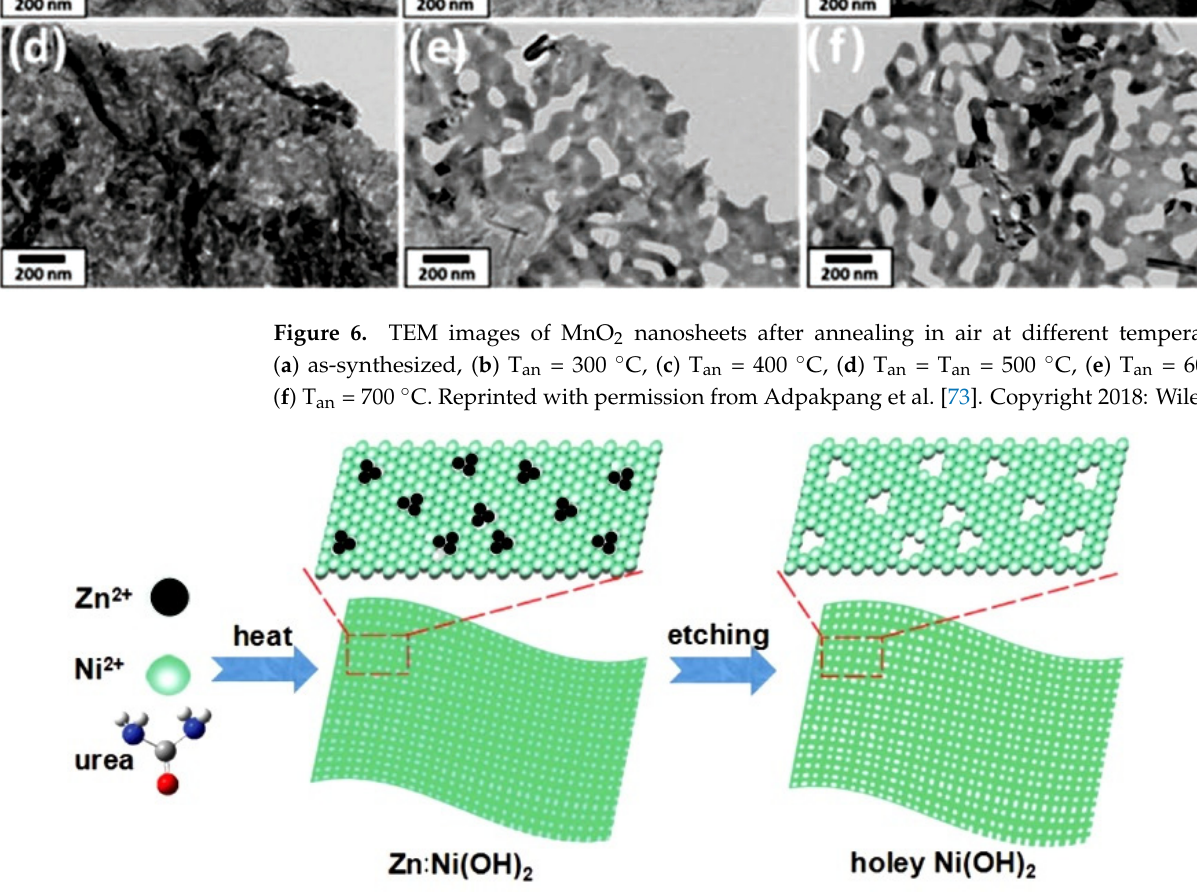
Figure 7. Schematic illustration for the formation of clean and freestanding tiny holey 2D Ni(OH) 2 nanosheets. Reprinted with permission from Kong et al. [76]. Copyright 2017: Wiley.